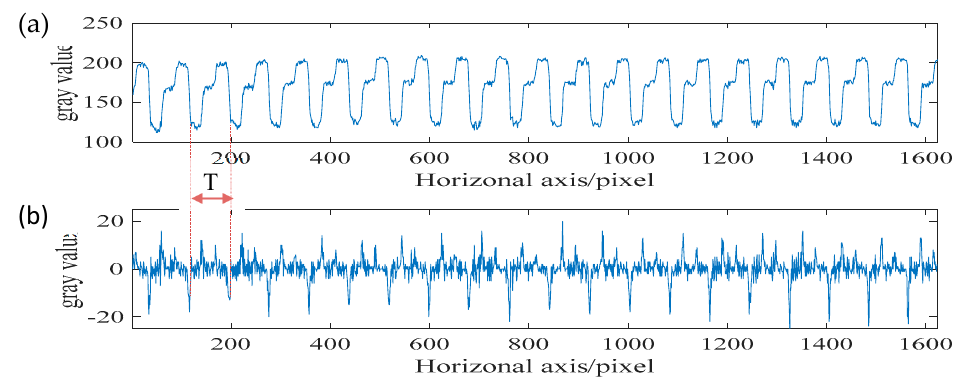
Figure 6. The gray value and differential value of the fringe patterns of the 513th row; ( a ) the distribution of the gray value; and ( b ) the distribution of differential value.